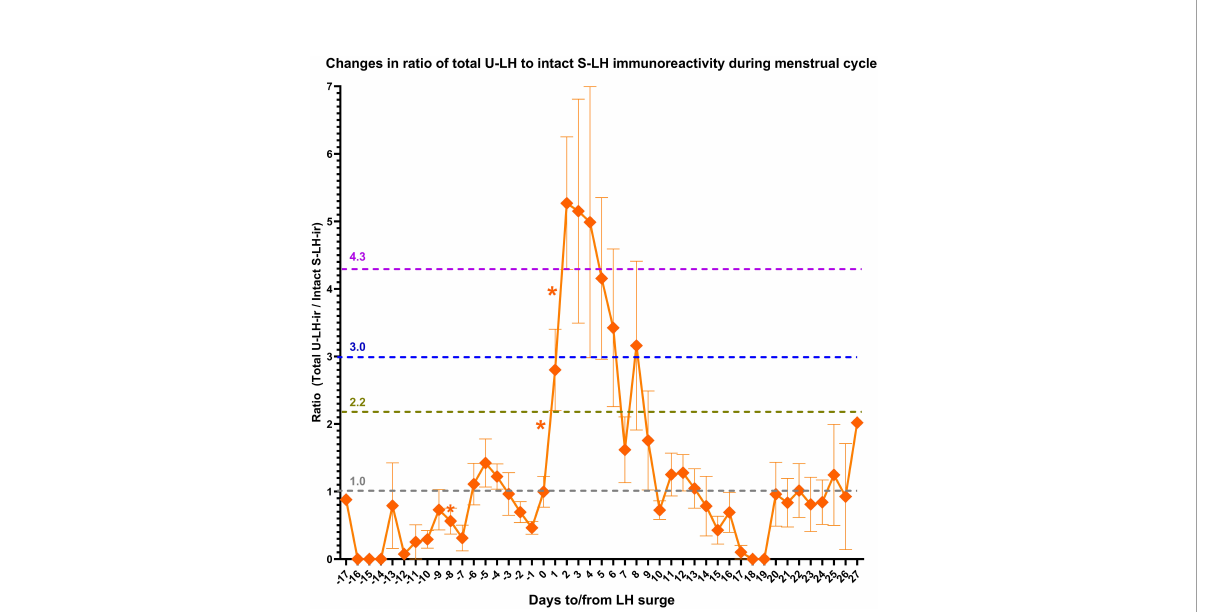
FIGURE 2 Changes in the ratio of total luteinizing hormone immunoreactivity (LH-ir) in urine to intact LH-ir in serum (representing the non-intact LH-ir in urine) during the menstrual cycle. Symbols depict the mean values and bars represent the standard error of the mean. The statistically signi fi cant changes are denoted as follows: *P<.05.